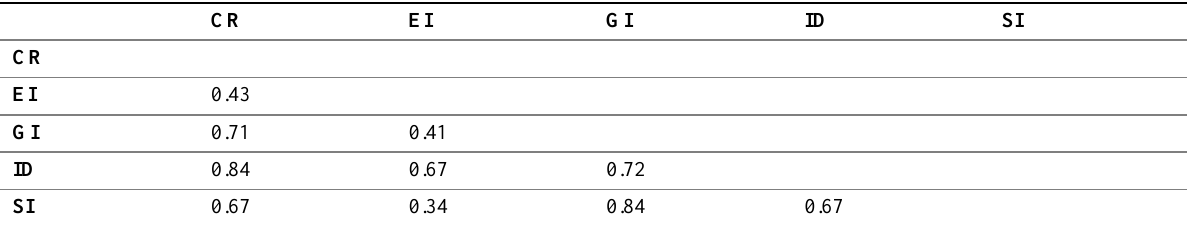
Table 42: Discriminant validity (Heterotrait-Monotrait Ratio - HTMT)